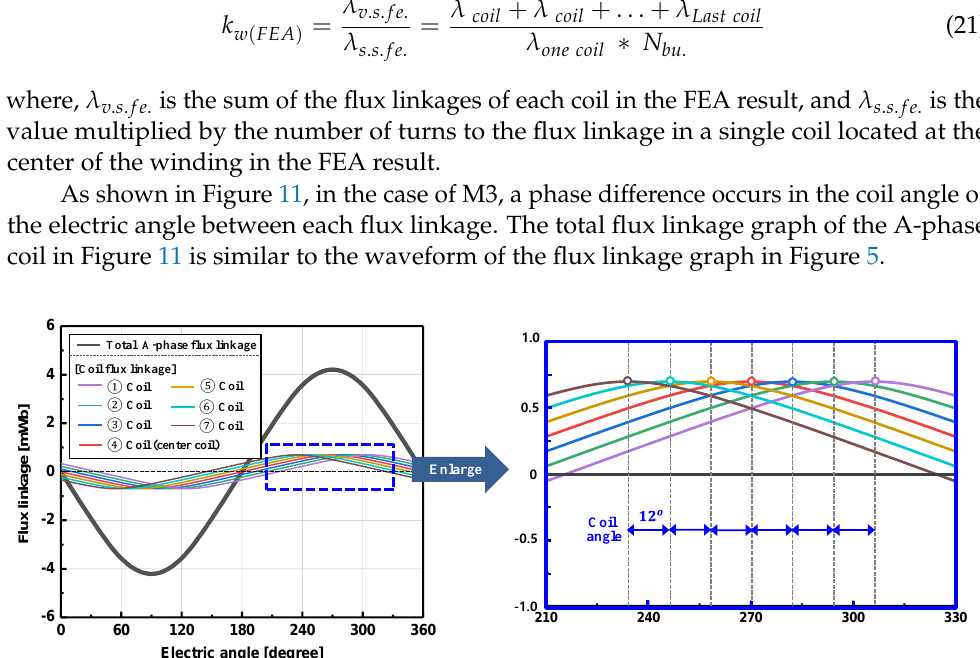
to the change in the winding angle are almost the same, within a 2% error. The calculated